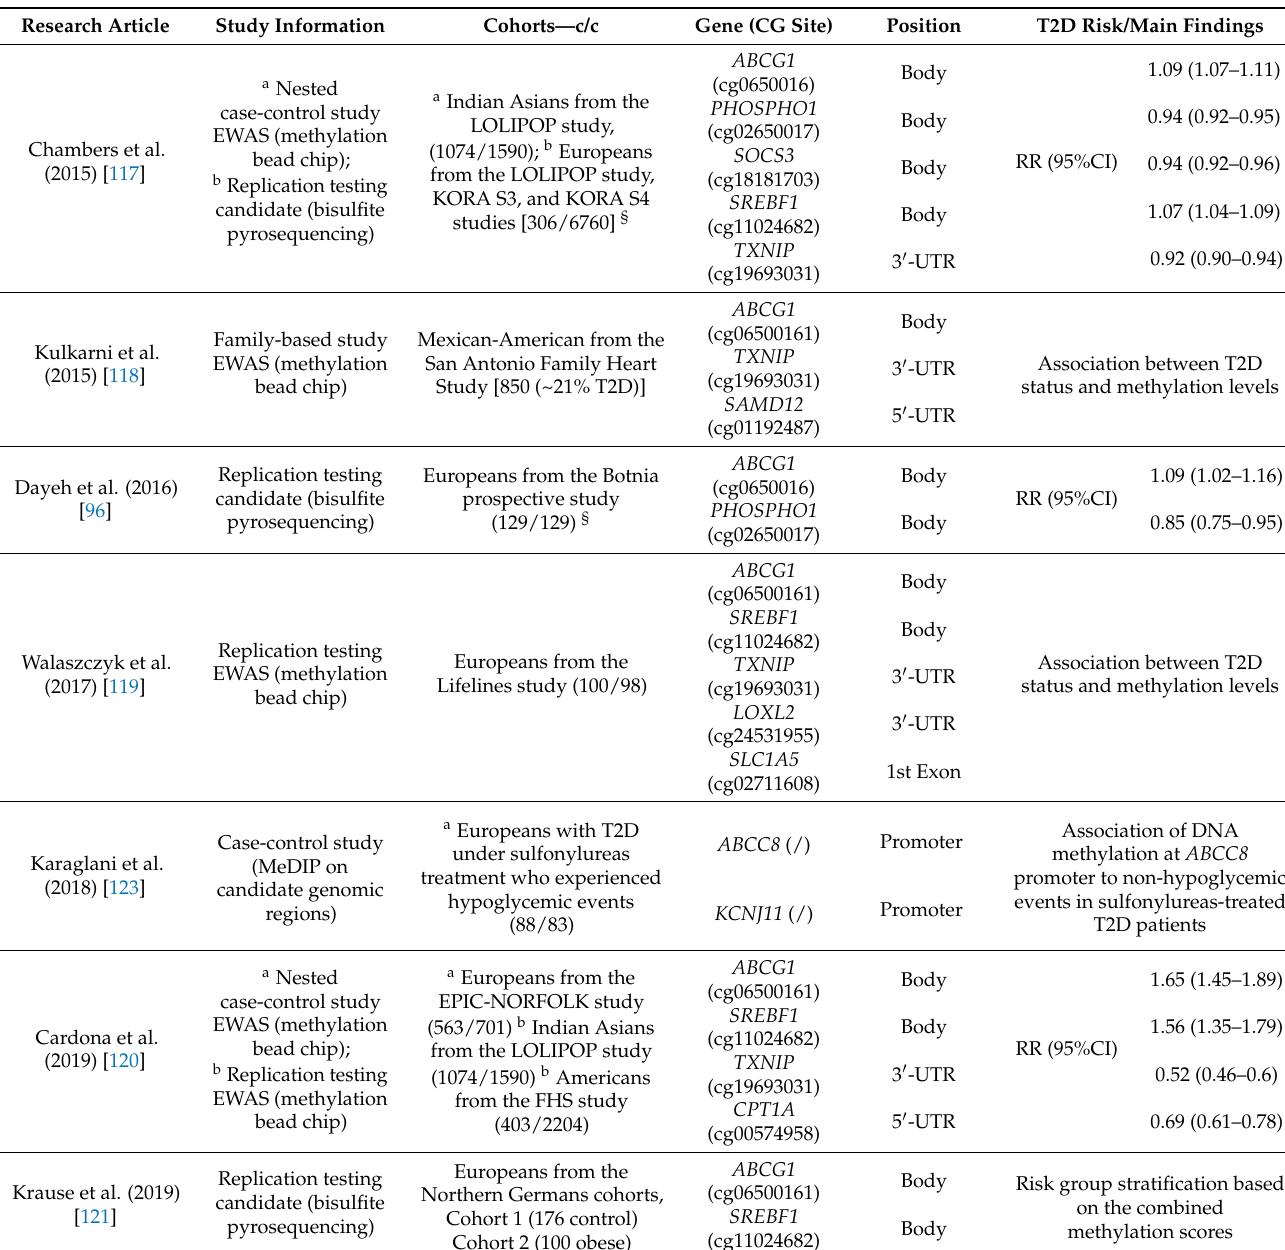
Table 2. Methylation Studies in